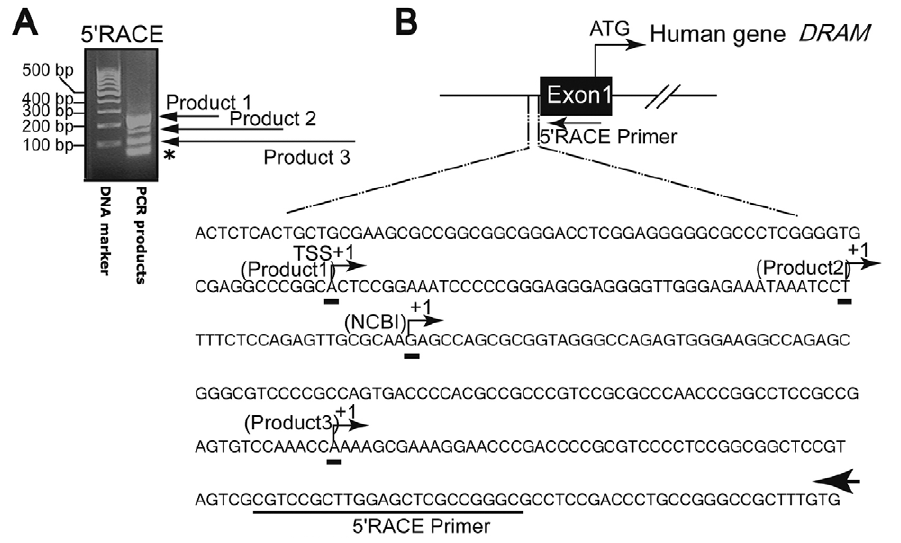
Figure 2. Identification of the transcription starting site by 5 9 RACE PCR. (A) Agarose gel showed multiple 5 9 RACE PCR products. (B) Mapping the potential TSS of the DRAM gene . Thearrow indicated thenested reverse 5 9 RACE primer. The GeneRacer PCR, based on RNA ligase-mediated and oligo-capping rapid amplification of cDNA, was carried out according to the manufacturer’s instructions. The PCR products were resolved on agarose gel, and potential bands were collected and confirmed by DNA sequencing. * indicates a non-specific amplification of the primer dimmers.